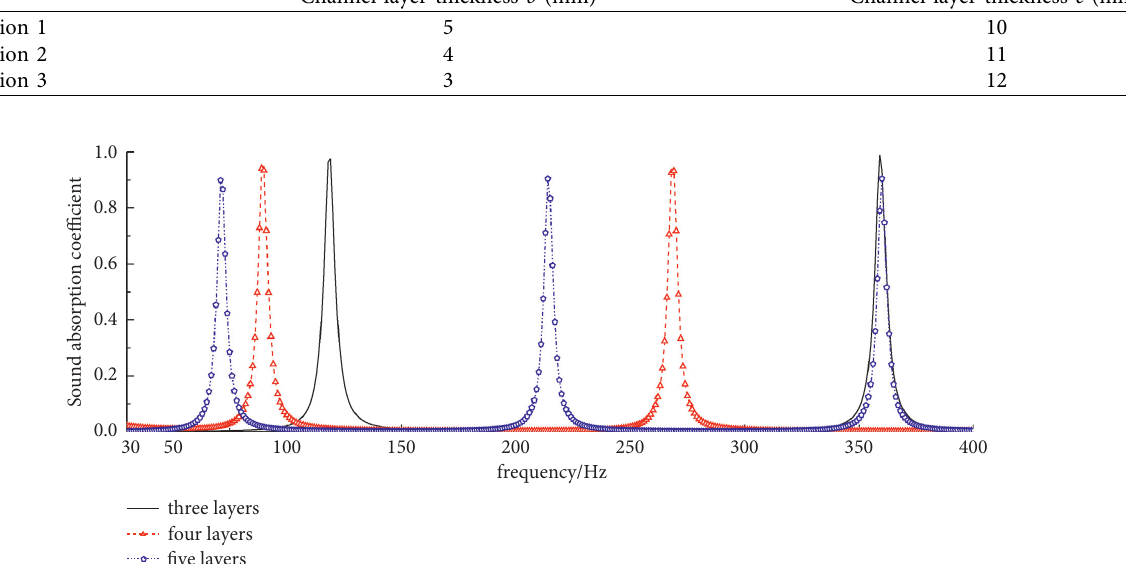
Figure 12: Sound absorption coefficient curves of metamaterials with different numbers of layers.